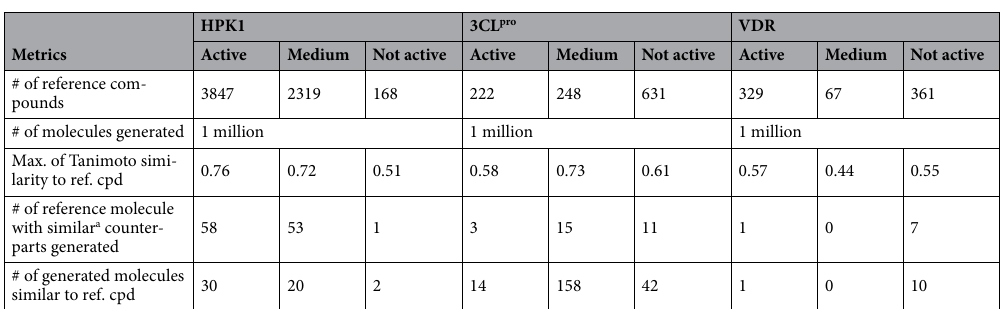
Table 2. Test for the generation of molecules similar to classical active compounds. a Similar: for a reference compound, if a generated molecule has over 0.5 Tanimoto similarity with it for ECFP4, then this reference compound is considered to have similar counterparts generated. The SMILES of the generated molecules and their similar reference compounds are provided in Supplementary material